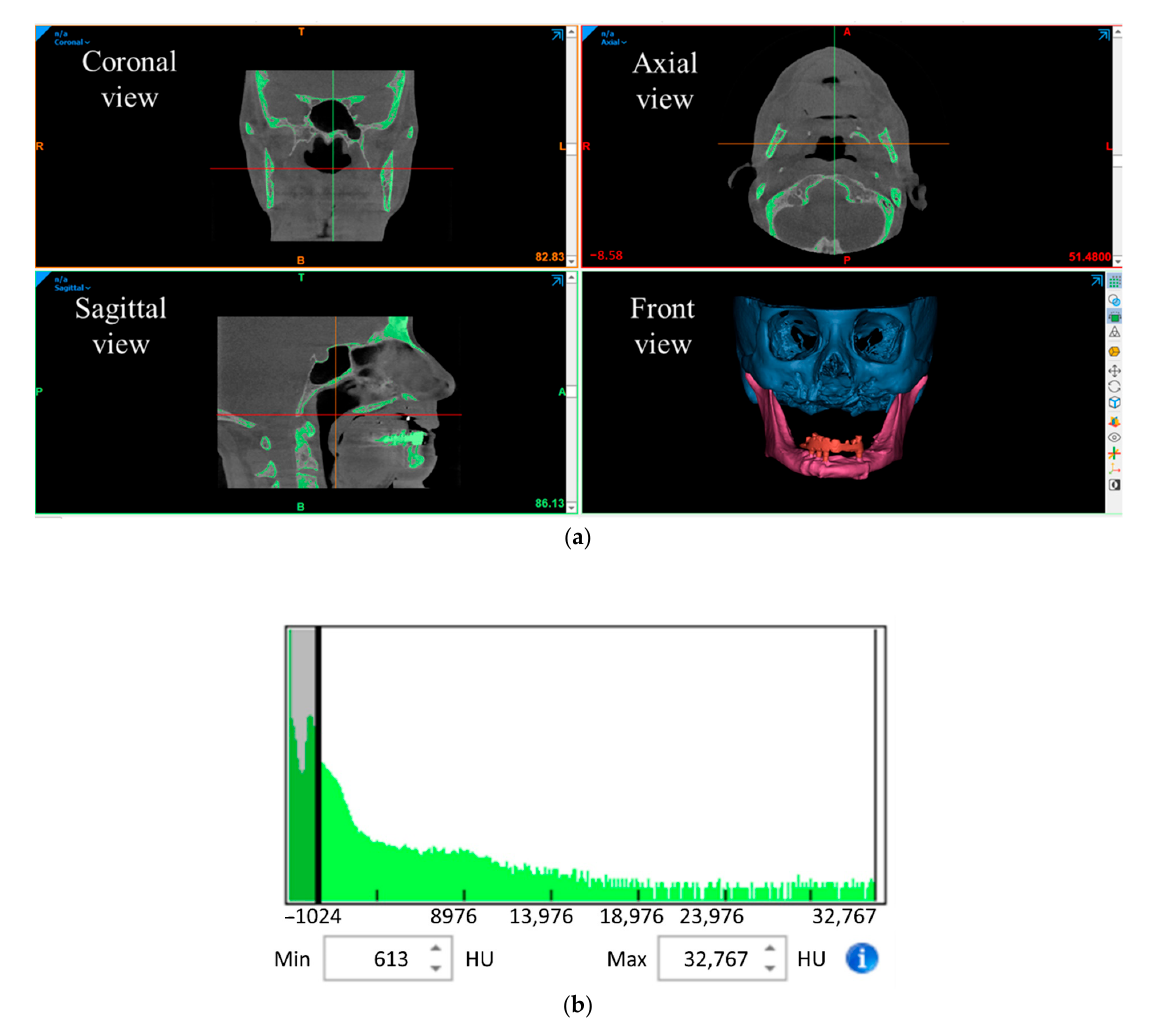
Figure 2. ( a ) Segmentation of maxilla and mandible bones from the overall facial anatomy: coronal, axial, sagittal, and front views; ( b ) Hounsfield radiodensity scale.